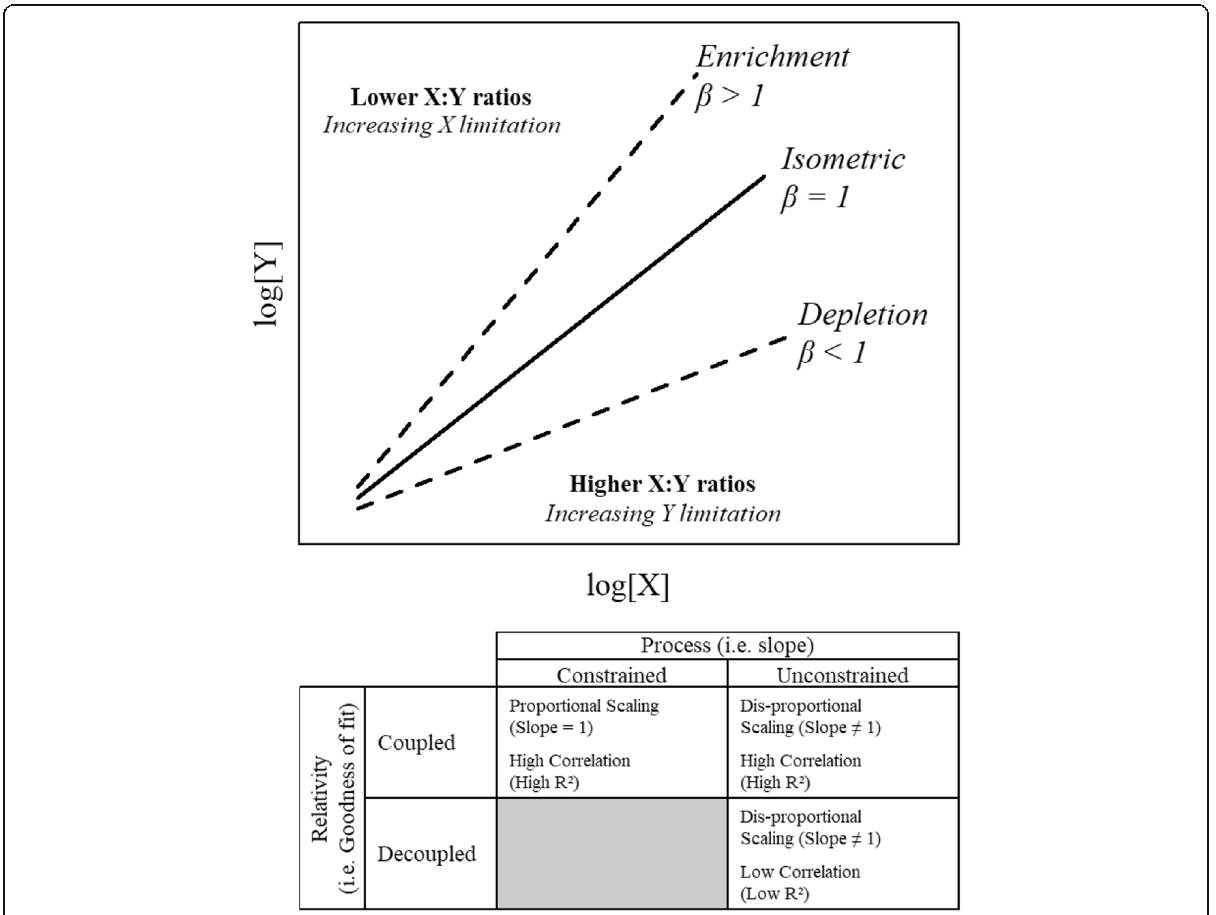
Fig. 1 Top: Conceptual model for power law slope ( β ) interpretation relative to log transformed nutrient concentrations and relationship to stoichiometric ratios (i.e., X:Y). Bottom: cross walk and function definitions of constrained/unconstrained and